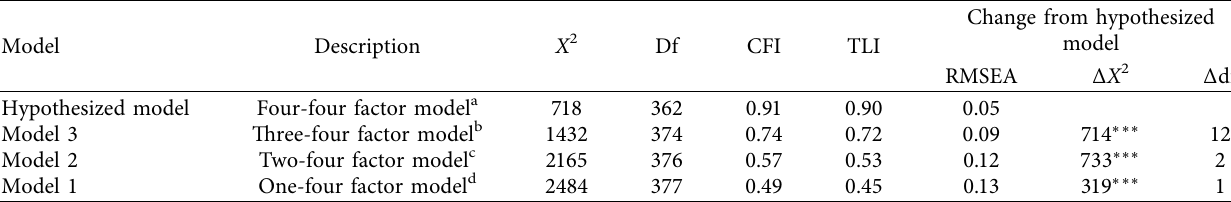
Table 2: Comparison of measurement models.